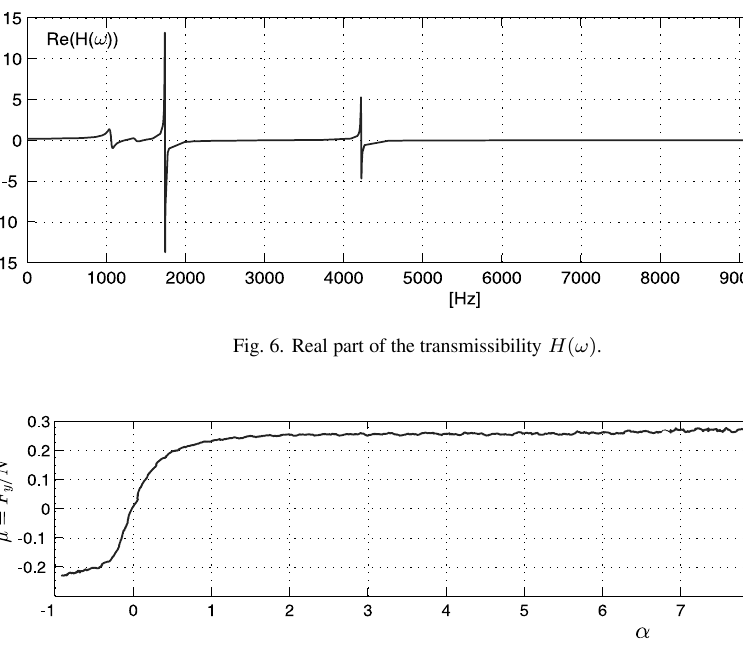
Fig. 7. Friction coef fi cient μ = F y /N as a function of the attack angle.